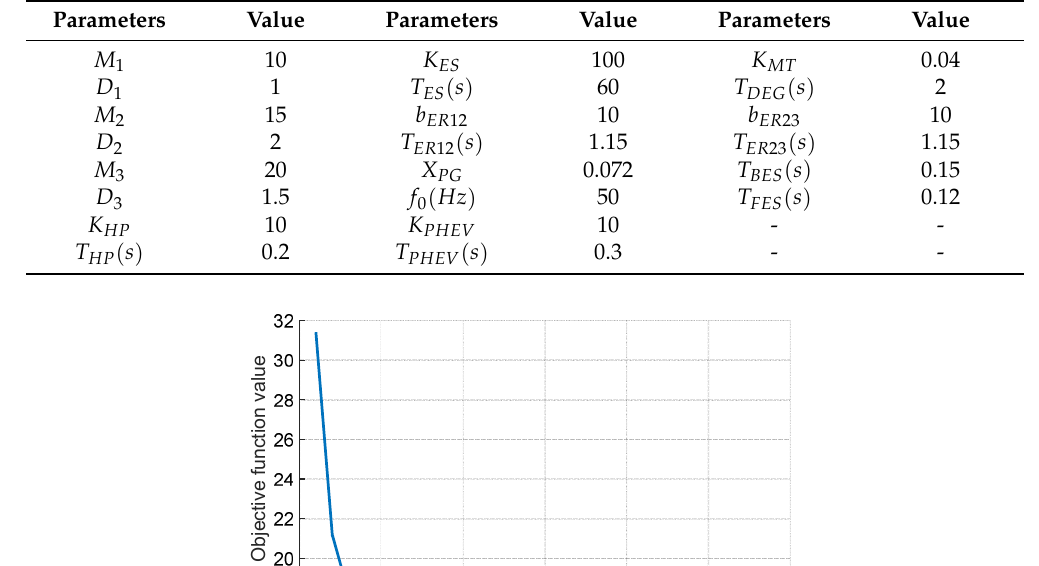
Table 1. System parameters.